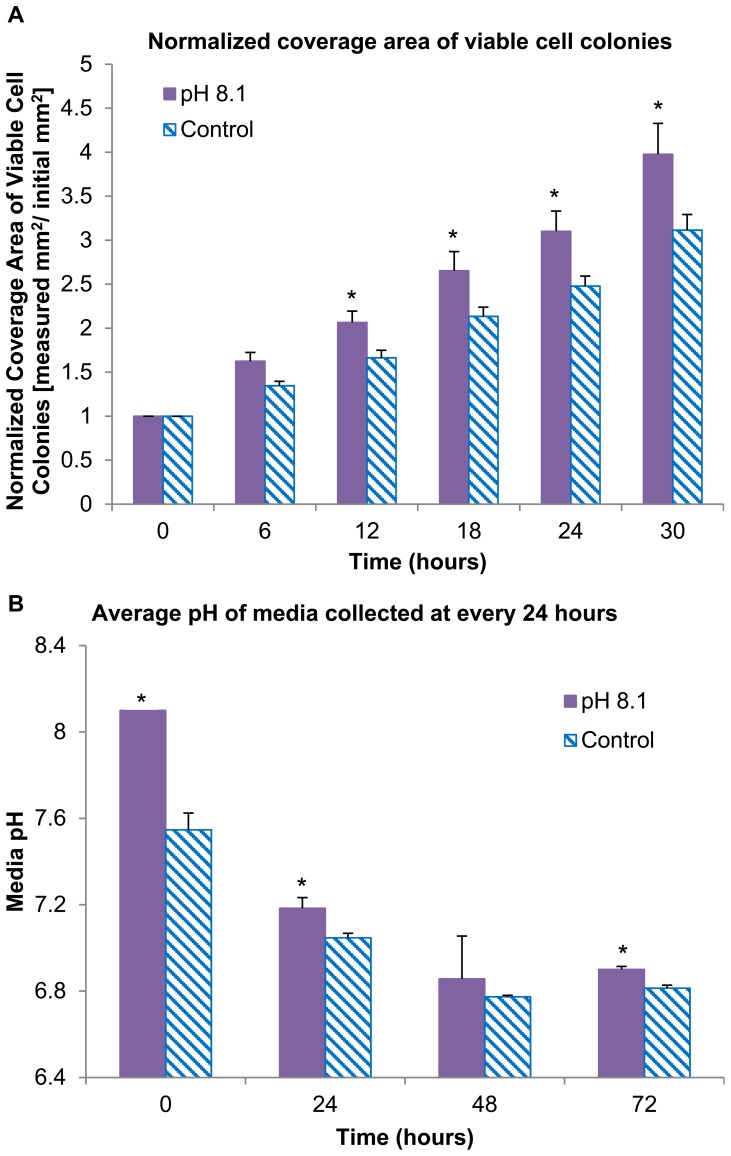
Coverage area of viable hESC colonies and pH of post-culture media under the alkaline or normal media conditions.(A) The coverage area of viable hESC colonies at 6–30 hours of culture after being normalized over the first time point at 6 hours. Values are mean ± standard error of the mean: n = 6. The hESCs cultured under the alkaline media condition proliferated and grew to confluency, indicating that the initial increase of media pH to 8.1 was not the direct cause of cell death observed in the cultures with the Mg samples. (B) The average pH of post-culture media collected at every 24 hours for 72 hours (*p<0.05 compared to the control). Values are mean ± standard deviation: n = 3.